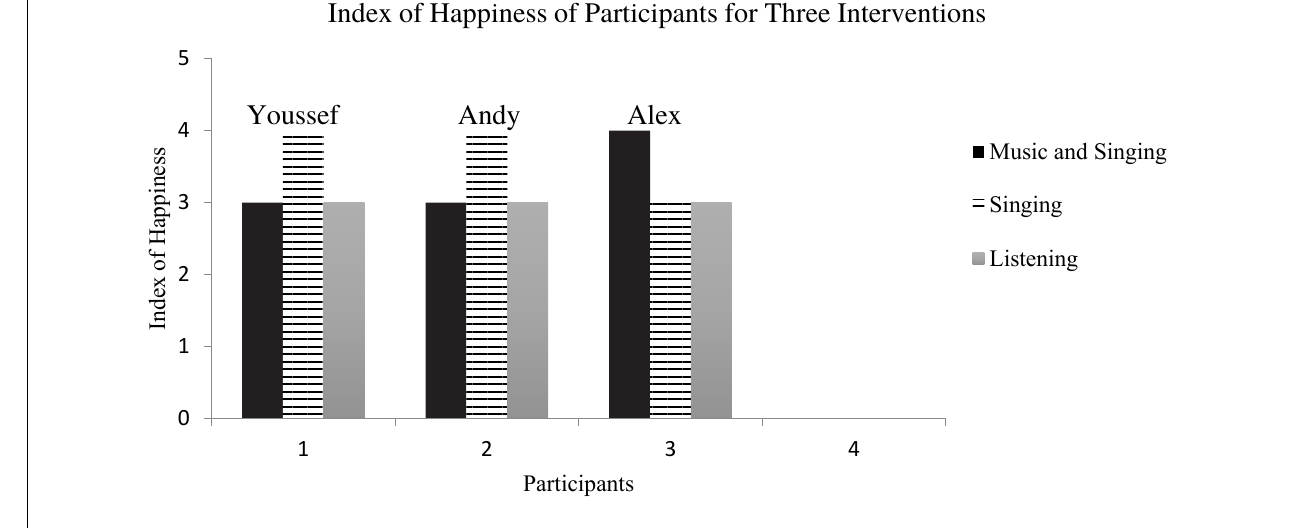
FIGURE 4 | Index of happiness for three music